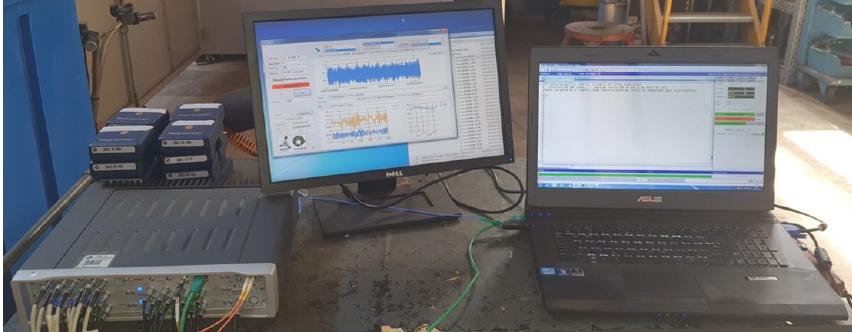
Figure 20. Simens LMS SCADAS ® used for signal acquisition for the mockup tower.